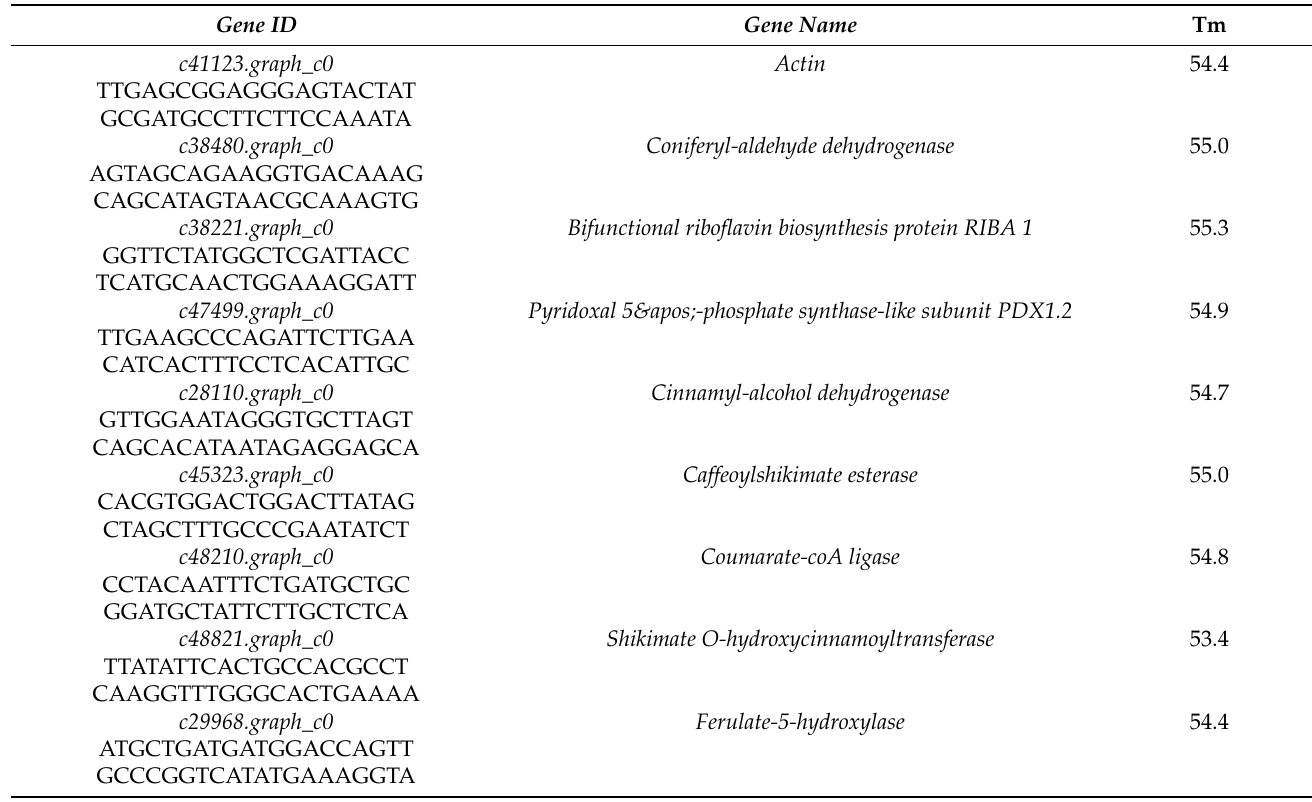
Table 1. List of primers for qRT-PCR